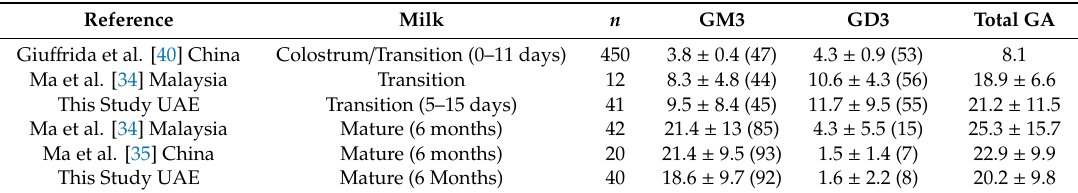
Table 5. Human milk mean GM3, GD3, and total ganglioside concentrations reported in the literature for both transitional and mature milk (mg / L ± standard deviation) a